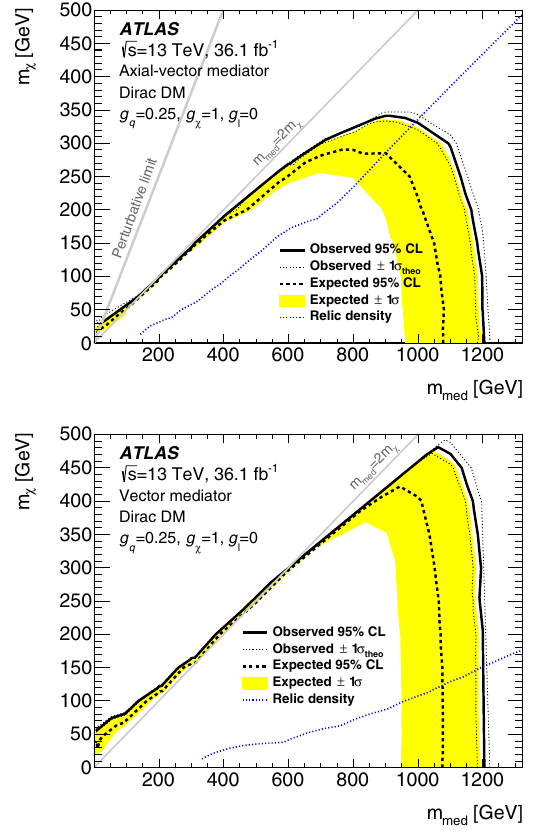
Fig. 4 The observed and expected 95% CL exclusion contours for a simplified model of dark-matter production involving an axial-vector operator, Dirac DM and couplings g q = 0 . 25 , g χ = 1 and g (cid:14) = 0 as a functionofthedark-mattermass m χ andthemediatormass m med ( upper left ). The plane under the limit curve is excluded. The same is shown for an axial-vector operator with couplings g q = 0 . 1 , g χ = 1 and g (cid:14) = 0 . 1 ( top right ), for a vector operator with couplings g q = 0 . 25 , g χ = 1 and g (cid:14) = 0 ( bottom left ) and for a vector operator with couplings